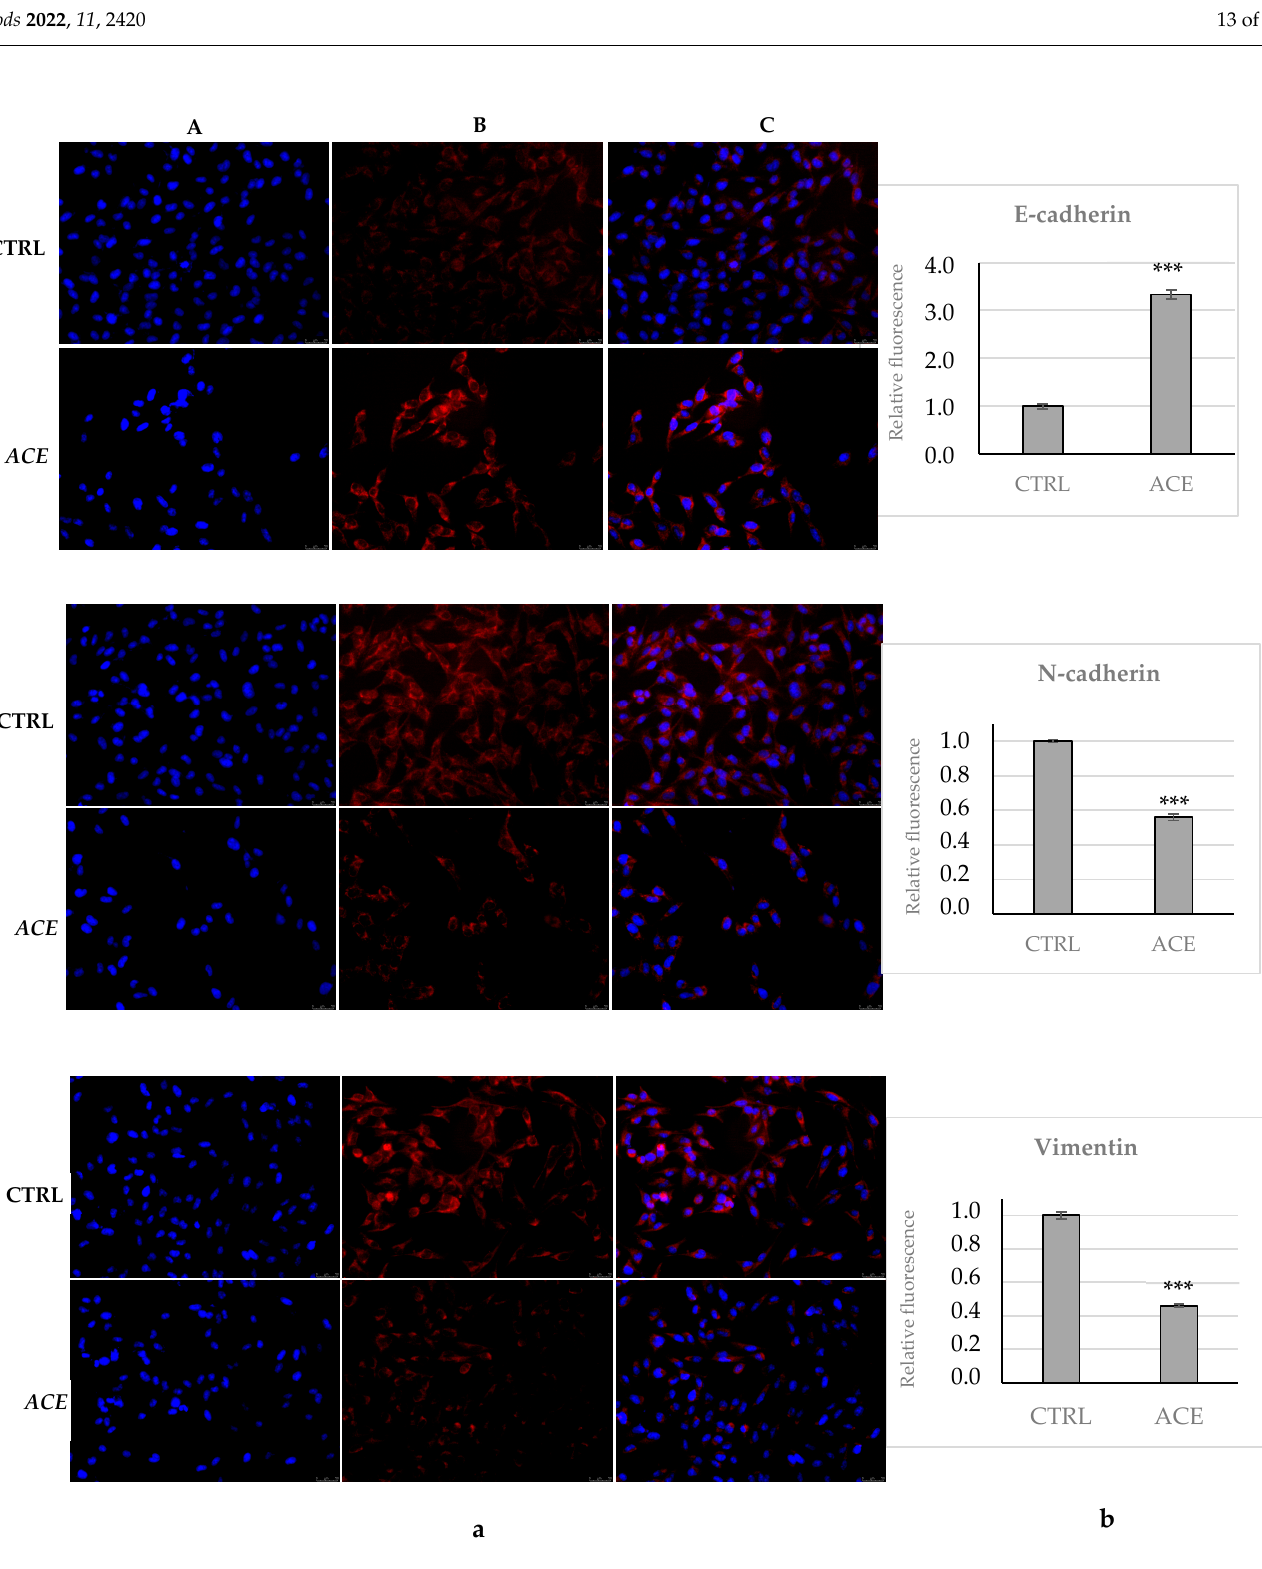
Figure 5. Immunofluorescence analysis of E-cadherin, N-cadherin and Vimentin. ( a ) A2058 cells were treated with ethanolic A. cherimola Mill. leaf extracts (ACE) at its IC 50 value or with vehicle (DMSO, CTRL). Images were acquired at 20 × magnification. ACE exposure increased E-cadherin expression and reduced N-cadherin and vimentin expression in A2058 cells. ( A ) DAPI ( λ ex/em = 350/460 nm); ( B ) Alexa Fluor ® 568 ( λ ex/em = 644/665 nm); ( C ) overlay channel. Images are representative fields of three independent experiments. ( b ) Fluorescence quantification was obtained using ImageJ. *** p < 0.001, ACE vs.